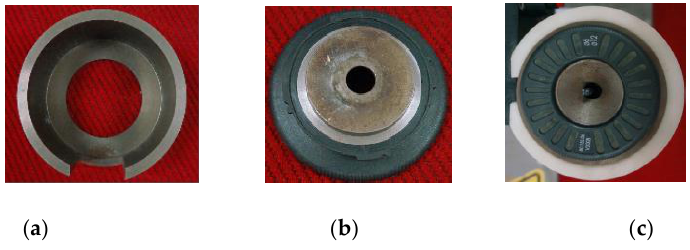
Figure 6. Structure of magnetic slot and magnetic ring: ( a ) magnetic slot; ( b ) bottom view of the magnetic ring; and ( c ) top view of the magnetic ring.